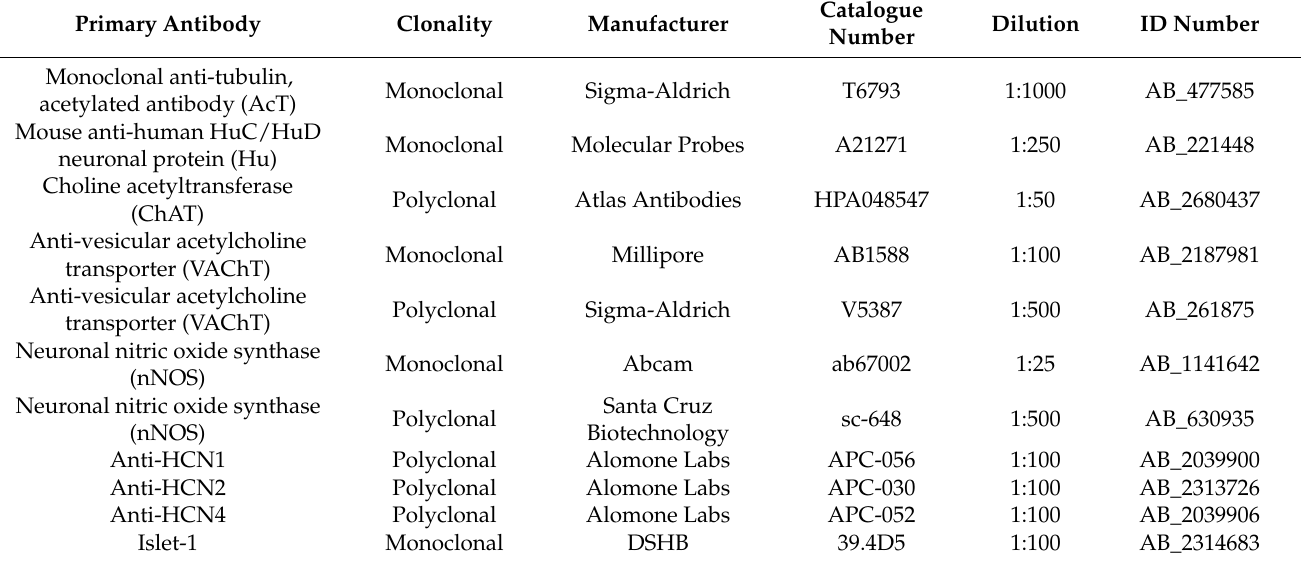
Table 1. Primary and secondary antibodies used in the present